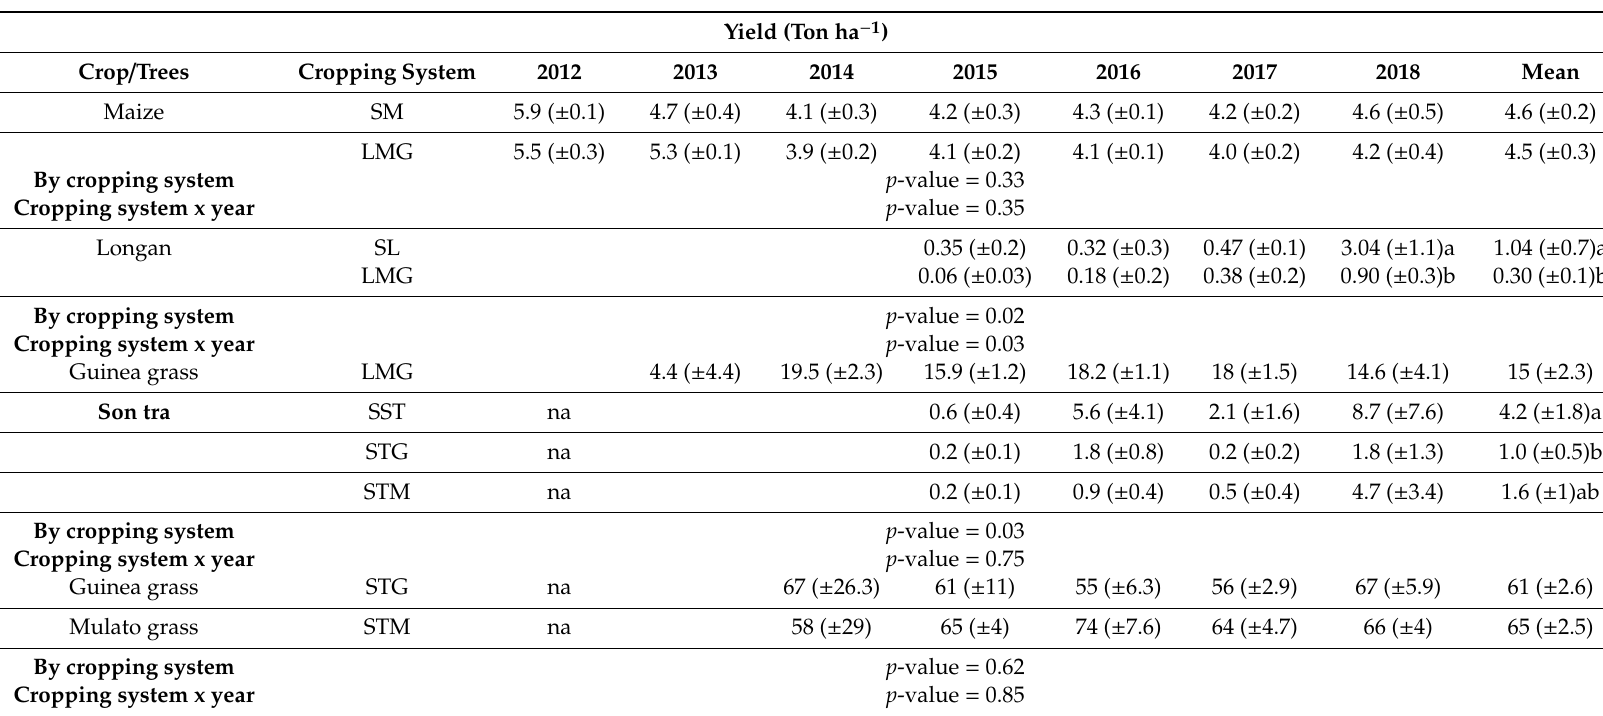
Table 1. Yield of maize (dry grain), longan, and son tra (fresh fruit) in sole-crop / tree systems (SM, SL, SST) and of these crops and forage grasses (fresh matter) in agroforestry systems (LMG, STG, STM) in the seven years of the field